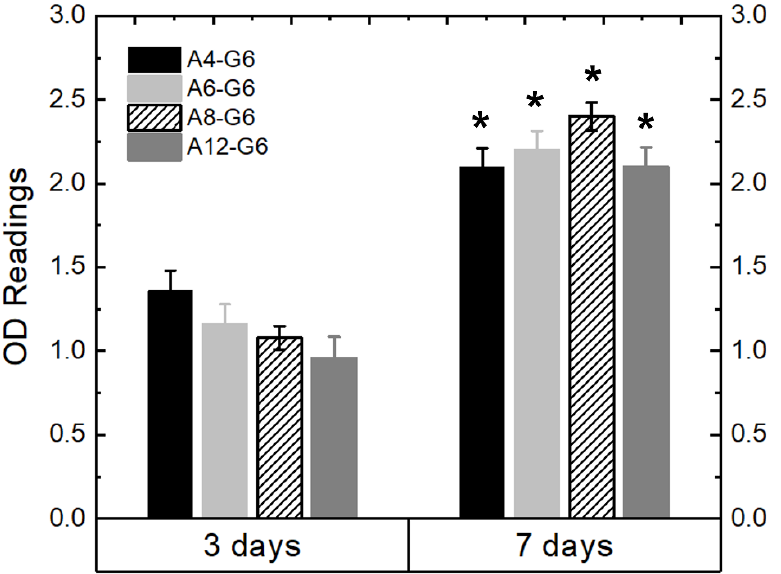
Figure 10. MTT assay results of the various printed scaffolds using C2C12 muscle cells. * means that the OD readings are statistically significant ( p < 0.05) with respect to the OD readings of the ‘3 days’ specimens.